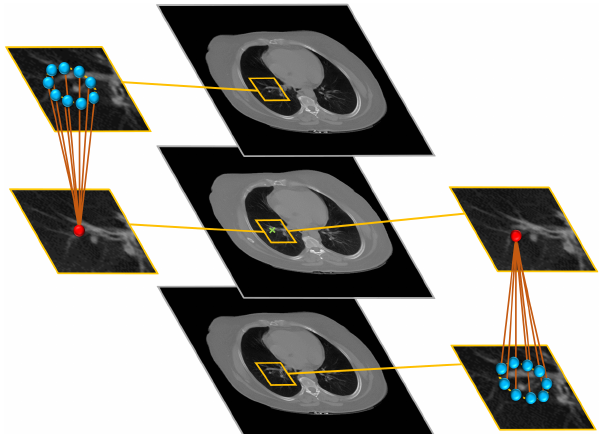
Figure 3. Illustration of the 3D MGRF-Based morphological constraints on the anatomical segmenta- tion. The middle column shows the selected slice, and its upper and lower slices; the left column shows the selected pixel and its neighbors at the upper slice while the right column shows the selected pixel and its neighbors at the lower